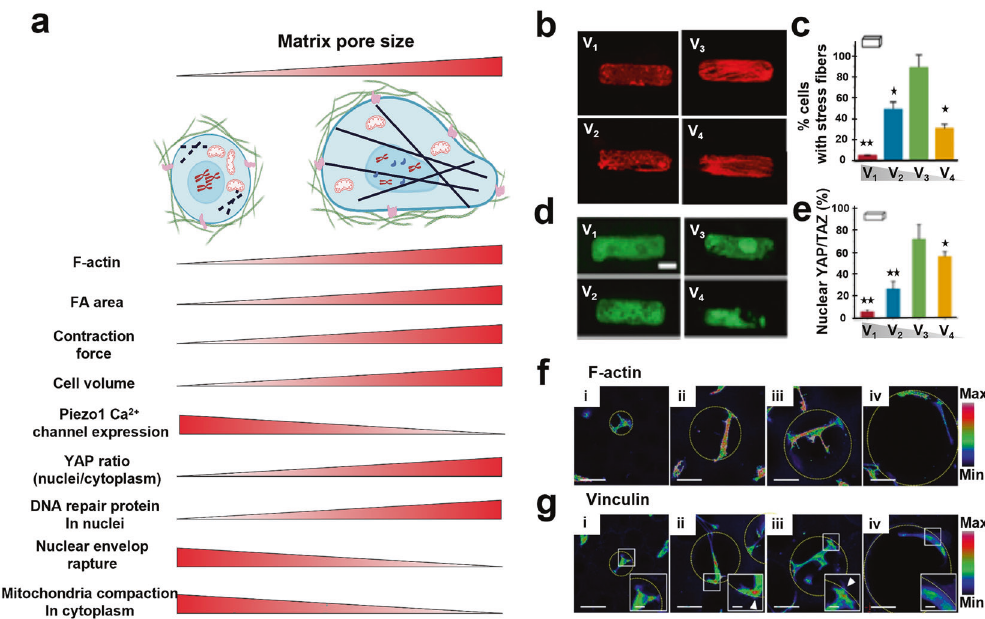
Fig. 4 The in fl uences of the pore size of hydrogel scaffolds on cell biology. a In fl uence summary of pore size on cellular compartment, molecular function, cytoskeleton arrangement, etc. The fi gure is made with biorender (https://biorender.com/). b – e Pore size (volume, V 1 > V 2 > V 3 > V 4 )-dependent cell stress fi ber formation ( b , c ) and YAP cytoplasm – nuclei translocation ( d , e ). * p < 0.05, ** p < 0.01. Reproduced with permission. 25 Copyright 2015, Springer nature. f , g A case focusing on how pore size (pore diameters: 47.0 ± 2.2 μ m (Group i), 84.8 ± 11.0 μ m (Group ii), 147.9 ± 7.2 μ m (Group iii), and 198.7 ± 9.1 μ m (Group iv)) affected F-actin ( f ) and Vinculin ( g ) expression in mesenchymal stromal cells. Reproduced with permission. 212 Copyright 2016, Springer